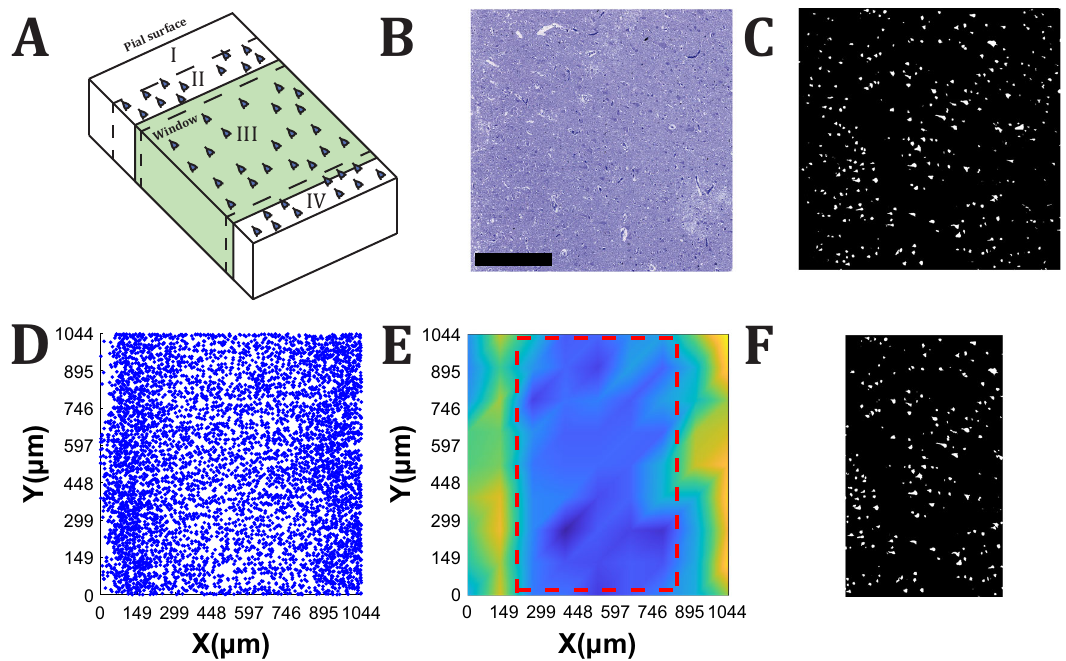
Fig. 4 Visualizing the steps to identify layer III. A) Illustration of four layers of BA46 and the observation window for the analysis is marked in green. B Raw image of a section. Scale bar = 300 μ m. C Binary image of the output from the Deep learning model, UNetDense. D Position of centroids from 200 images projected to the x - and y -plane. E Density map of the positions of neurons to visualize the different layers in the cerebral cortex and the yellow color represents areas of high density, whereas the blue color represents areas of low density. The density was high at the yellow areas, which indicate the position of layer II and layer IV (from left to right) and low at the blue areas, which indicate fewer neurons and show a part of layer I and layer III. The volumetric stack of images was cropped within the squared marked with the red dashed lines that was selected by a user. F The part of the image in C, which is chosen for